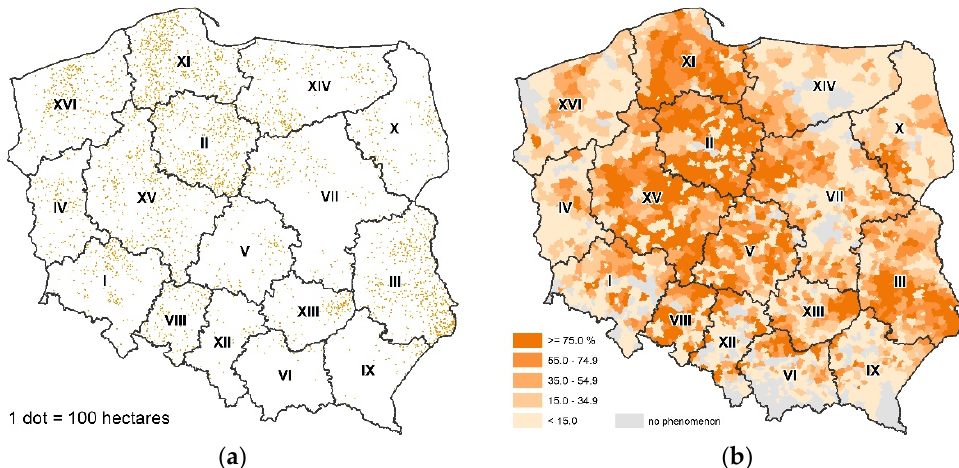
Figure 5. Area of land subsidised with support for environmental agriculture ( a ), and its share in the total area covered by pro-environmental RDP support ( b ). Source: own elaboration.